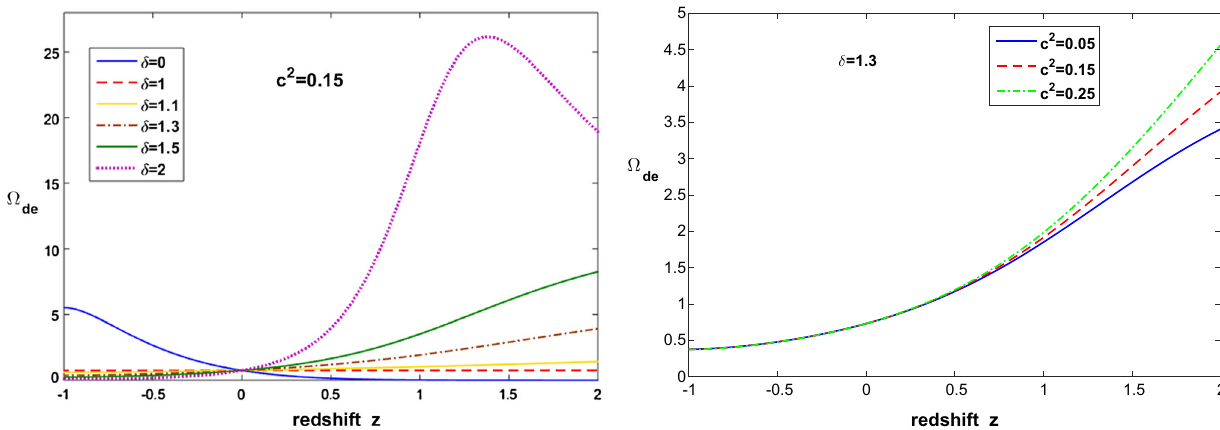
= 0 . 73, u = 0 . 3 and de